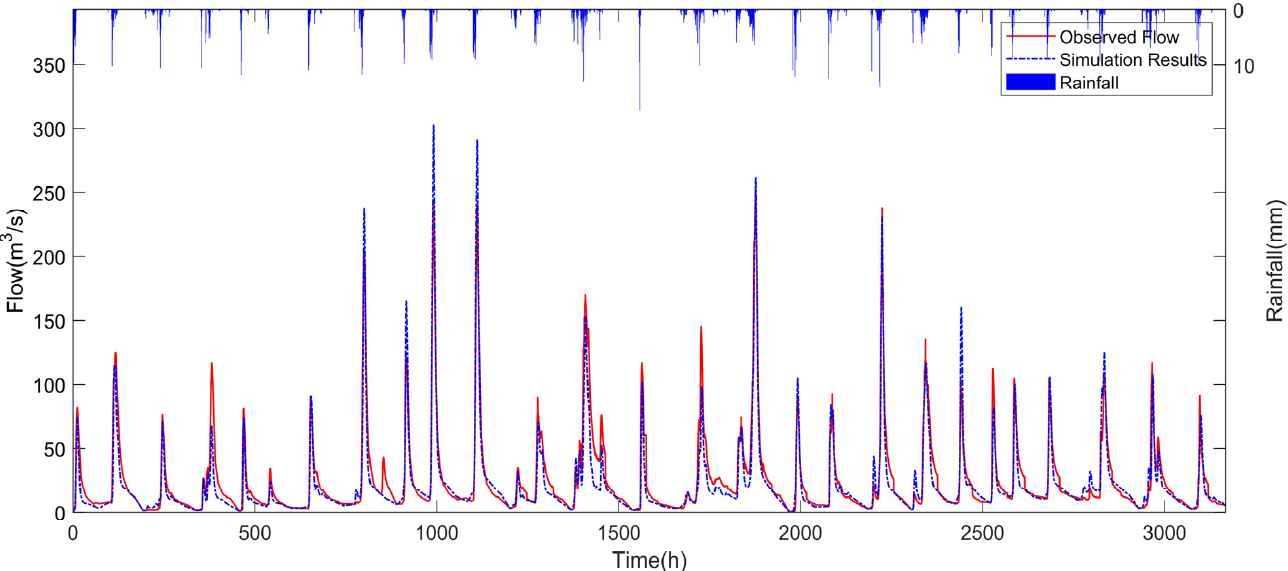
Figure 6. Comparison of observed and simulated hydrograph of LianYuan station.